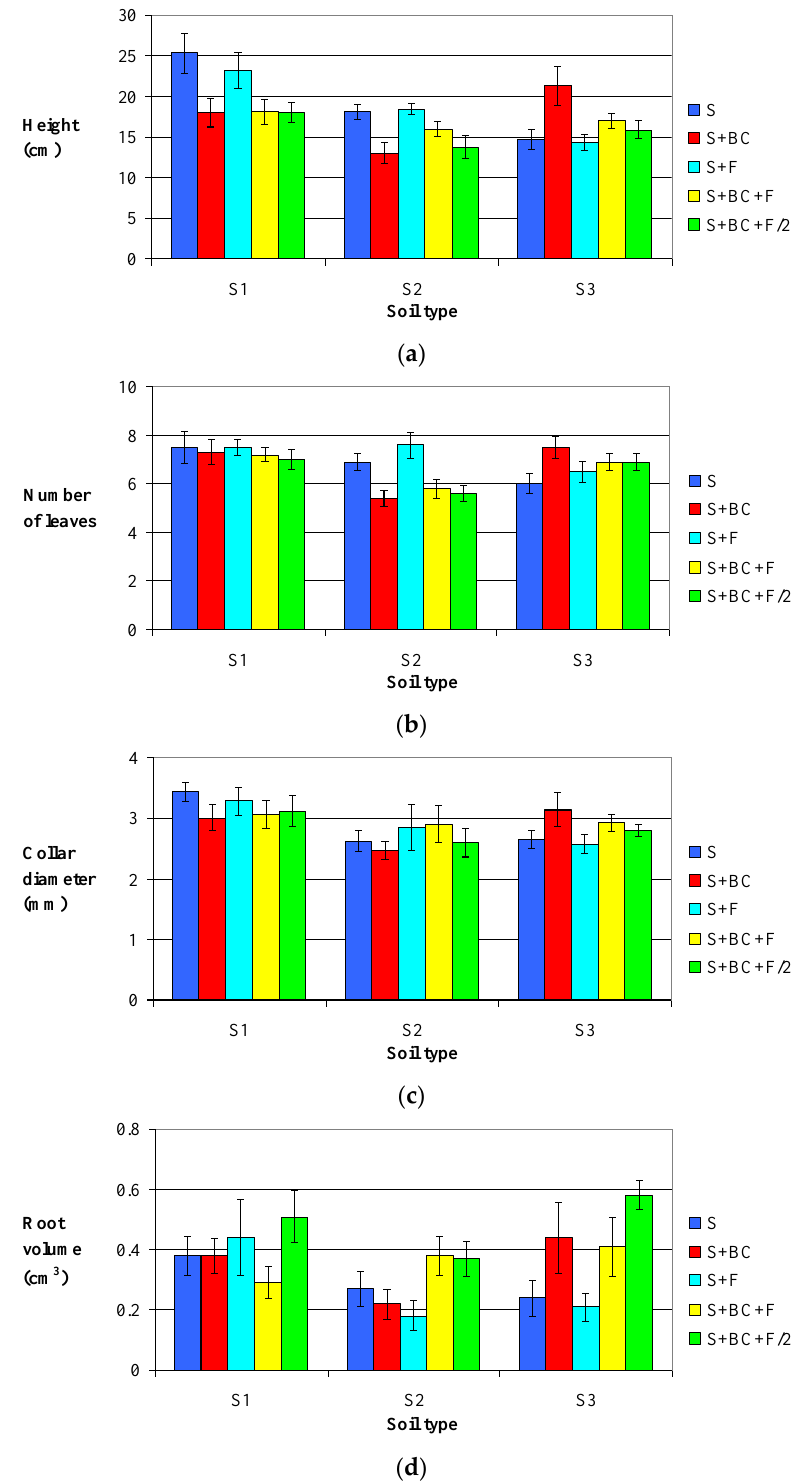
Figure 4. Values (mean ± margin of error) of plant height ( a ), number of leaves ( b ), collar diameter ( c ), and root volume ( d ), 66 days after sowing: (S1) Fluvisol soil; (S2) Chernozem soil; (S3) Luvisol soil; (F) foliar fertilizer (0.2%); (F/2) foliar fertilizer (0.1%). BC had a beneficial effect on NL of plants grown in soil S3 and no favourable effect on NL of plants grown in soils S1 and S2 (Figure 4b). The mean value of number of leaves ( NL m ) of plants grown in BC-amended soil S3 without foliar treatment (S3 + BC), i.e.,